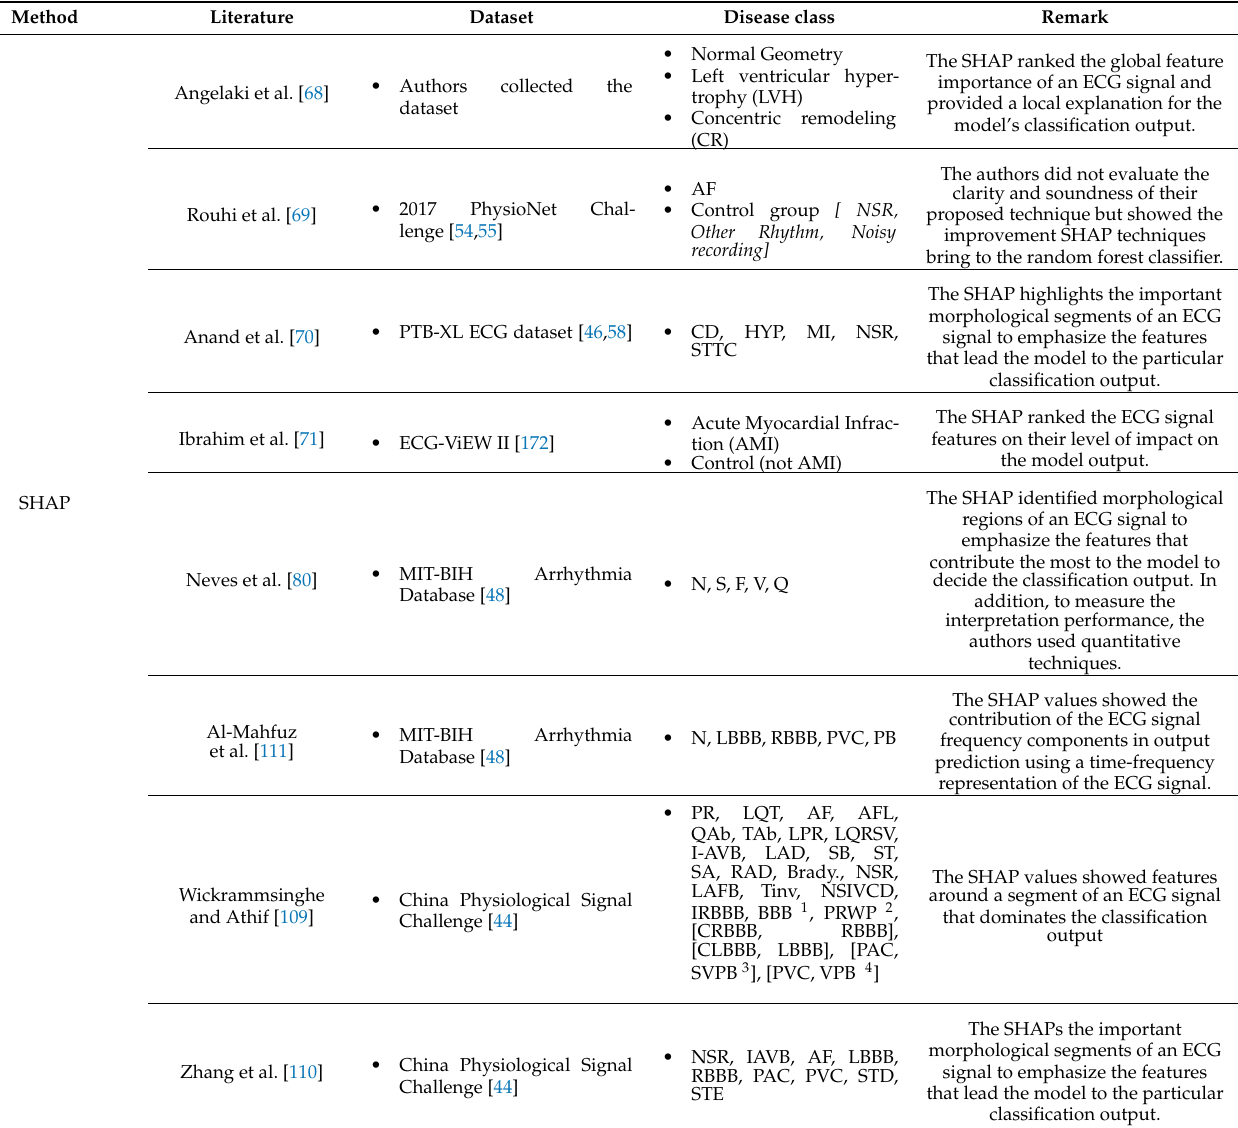
Table 10. Analysis of the feature effects via SHAP, feature importance, and a LIME-based IML performance